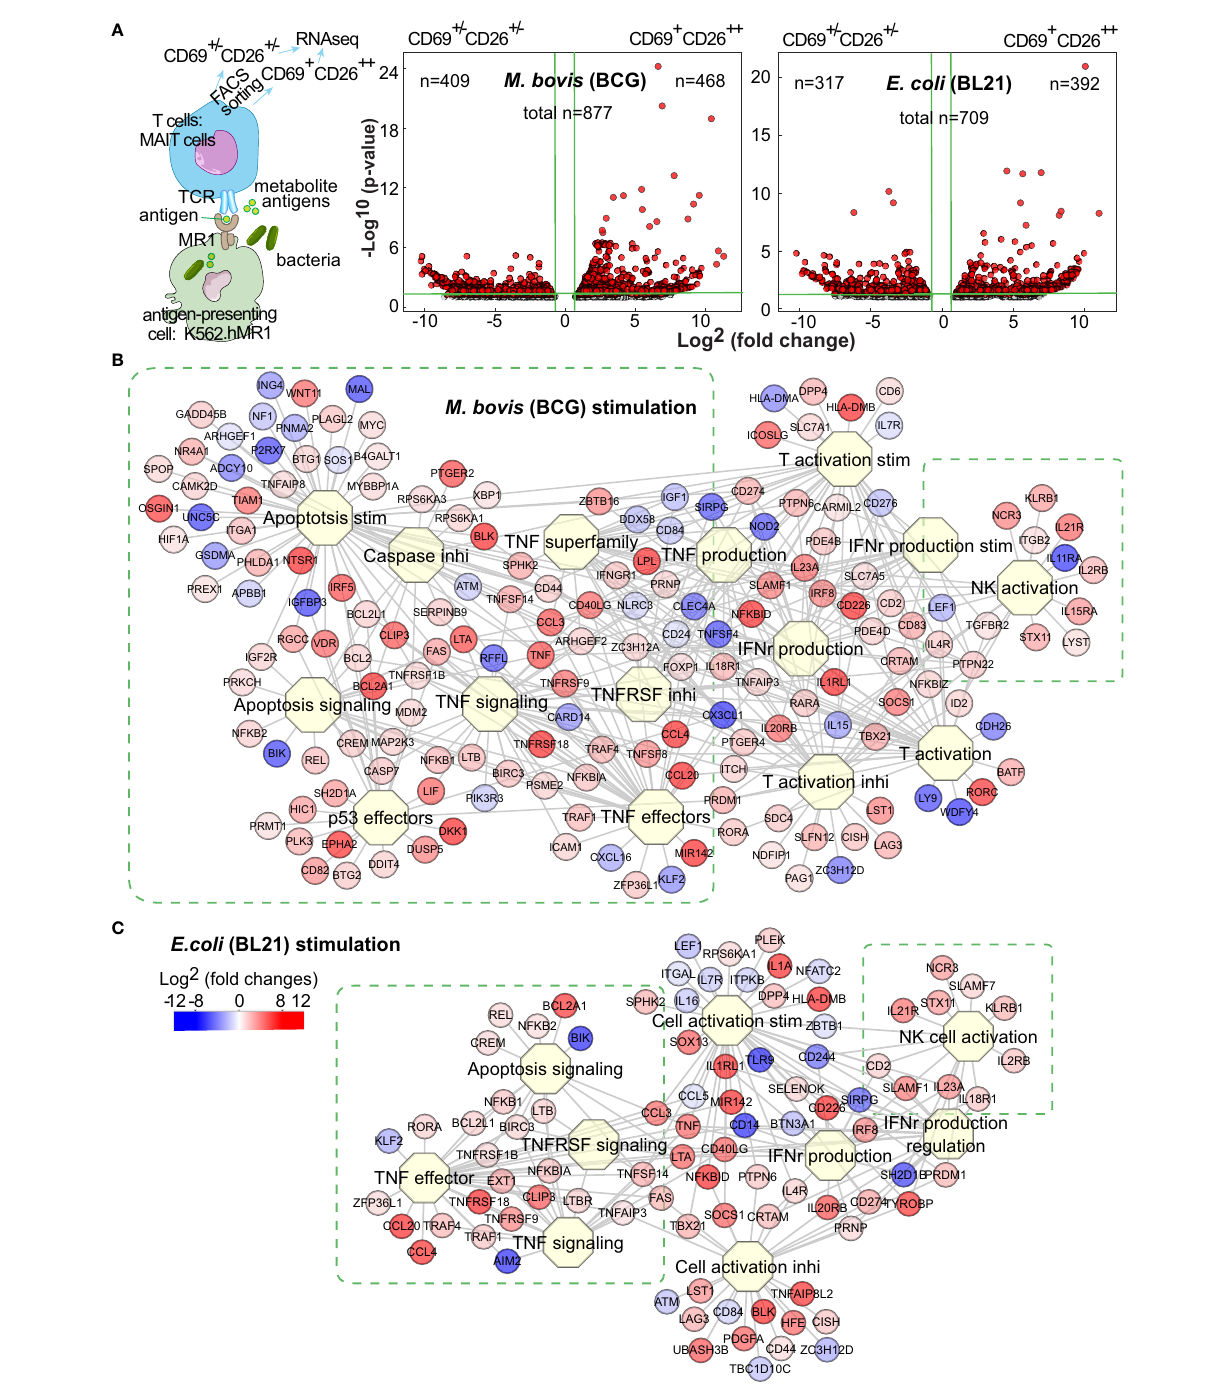
FIGURE 1 BCG and E.coli stimulate different MAIT cell transcriptomes. Anti-V a 7.2-enriched MAIT cells from blood of healthy donors were co-cultured overnight with bacterial-infected K562.hMR1 cells together with anti-CD28 antibody, then gated on V a 7.2 + CD161 + CD4 - CD8 + cells, and further sorted into activated versus inactivated MAIT cells labeled with CD69 + CD26 ++ and CD69 +/- CD26 +/- , respectively ( A , Figure S1). The sorted activated vs. inactivated MAIT cells were used for RNA puri fi cation and next-generation sequencing. Based on the sequencing results, differentially expressed genes (DEGs) were identi fi ed using the edgeR package in R program and shown in Volcano plots as red dots. On the plots, vertical green lines label two-fold changes in intensity counts, and horizontal green lines label p-values of 0.05. For activated MAIT cells between BCG and E. coli stimulations, the horizontal green line label a p-value of 0.1 (A) . DEGs were used to search biological processes and pathways through the Toppcluster program. Results show multiple functional clusters associated with cell proliferation, apoptosis, cytokine regulation, and cell activation upon BCG and E. coli stimulations (B, C)